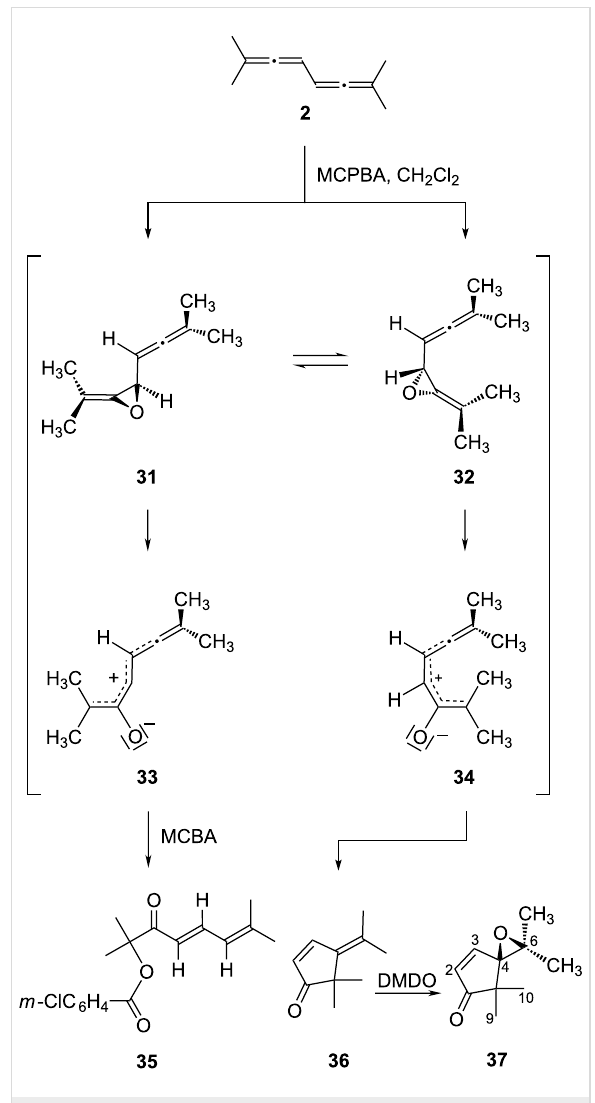
Scheme 7: Oxidation of conjugated bisallenes with different oxidizing agents according to